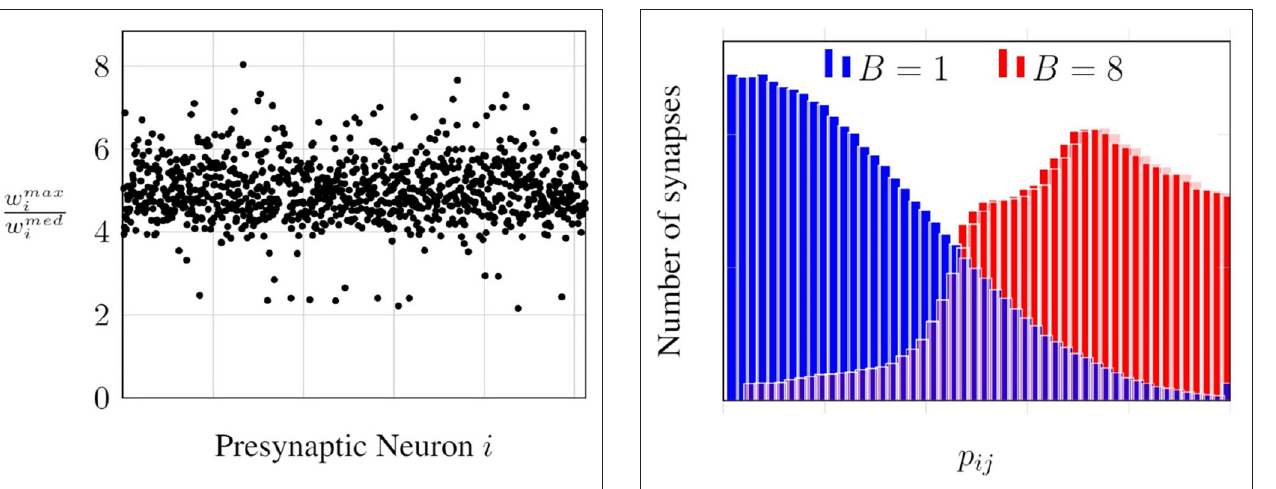
presents histograms for spike propagation probabilities across synapses in the same layer as Figure 5 .